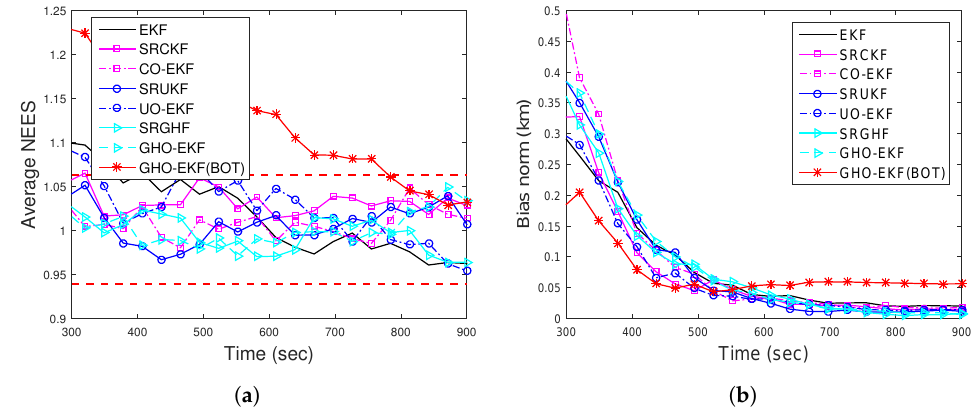
Figure 9. ( a ) ANEES; ( b ) position bias norm of the DBT for Scenario